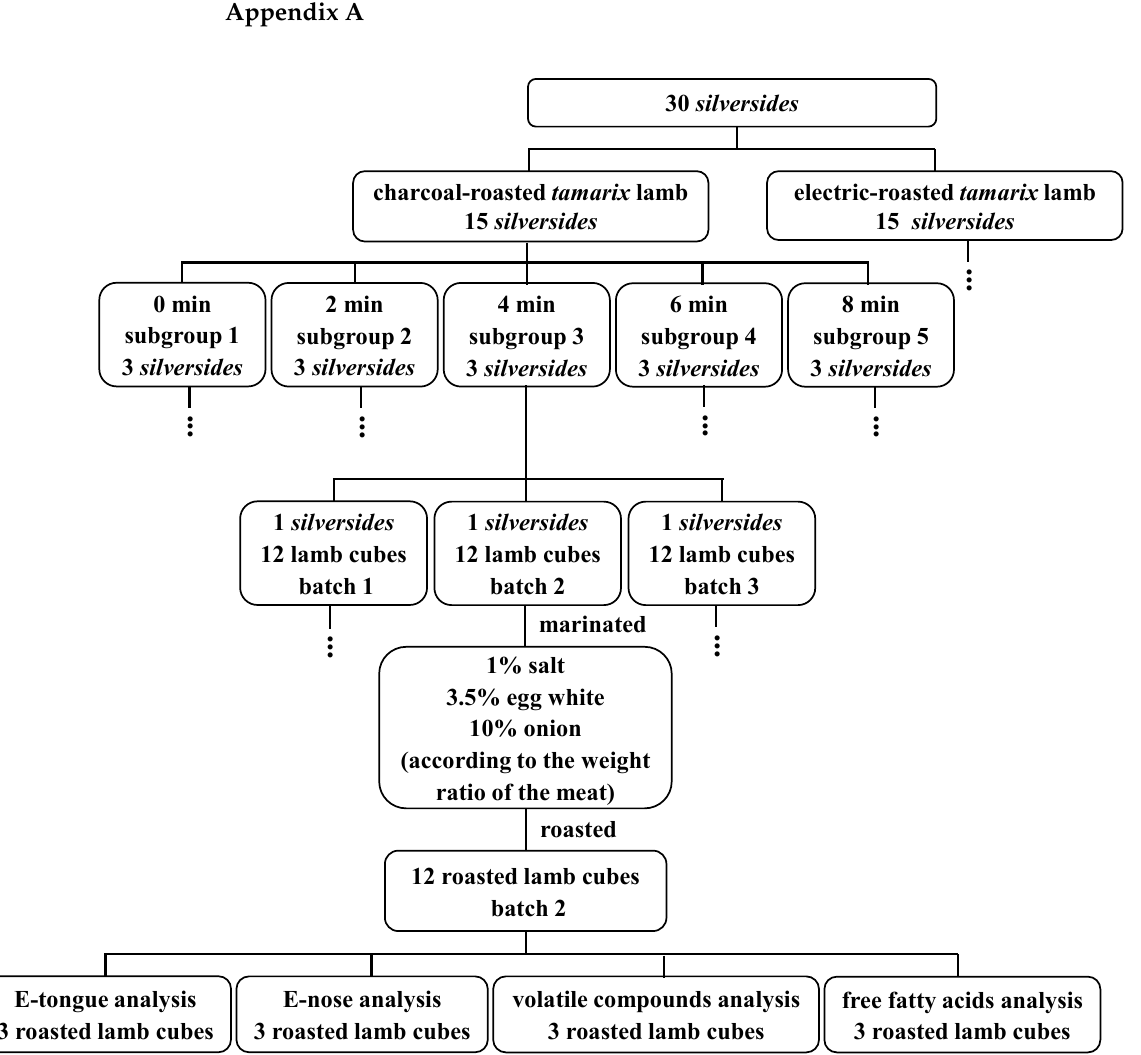
Figure A1. Flow chart showing the major roasted tamarix lamb preparation steps.